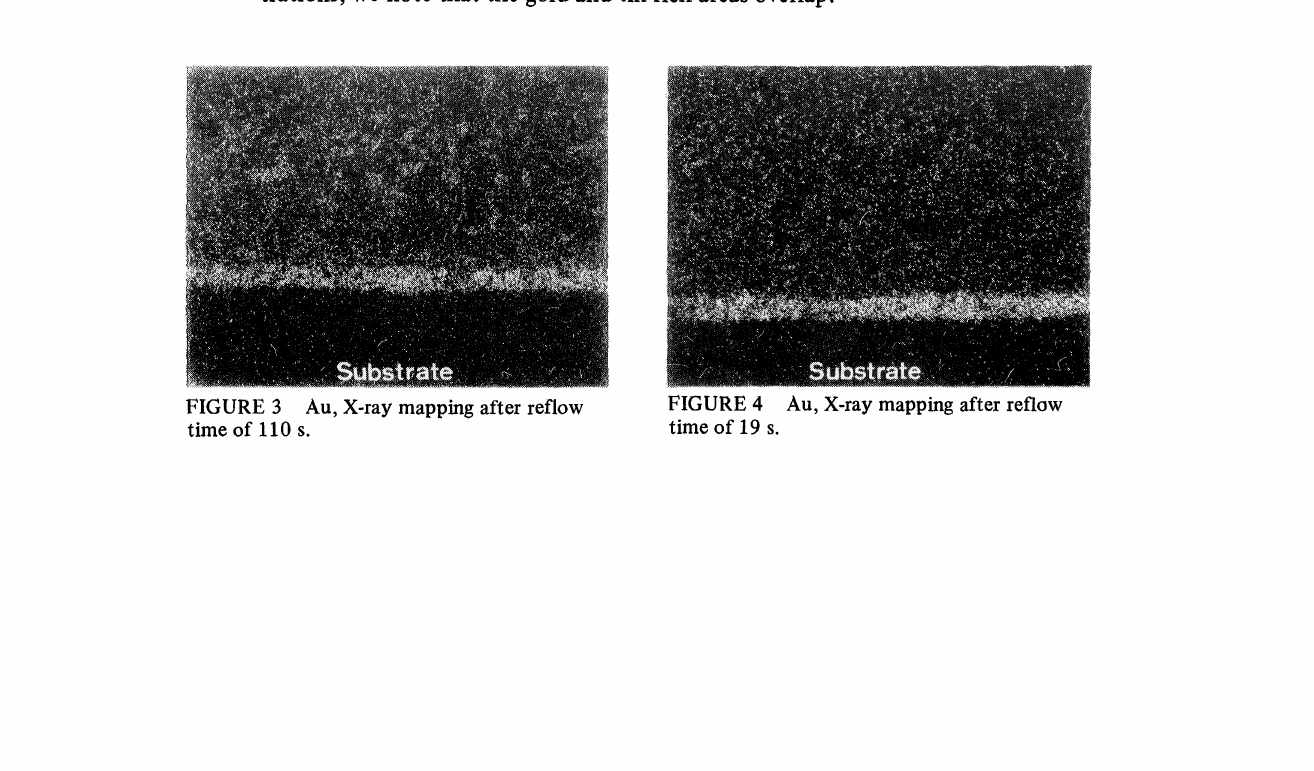
FIGURE 3 Au, X-ray mapping after reflow time of 110 s.